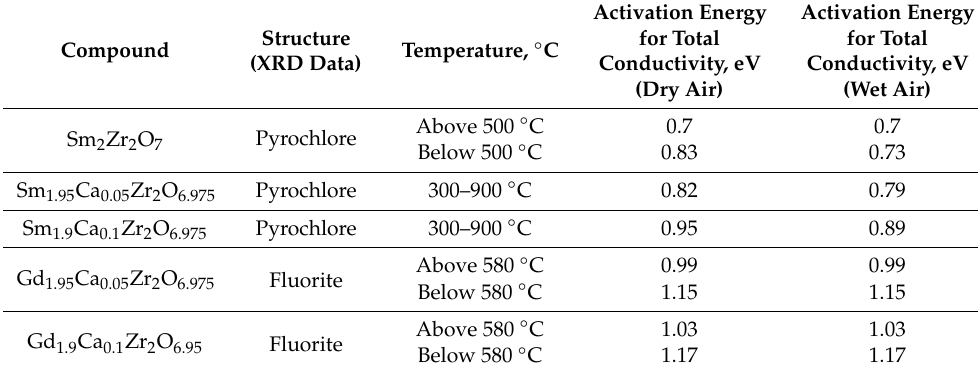
Table 4. Activation energy for total, bulk and gb conductivity in ambient air in the compounds